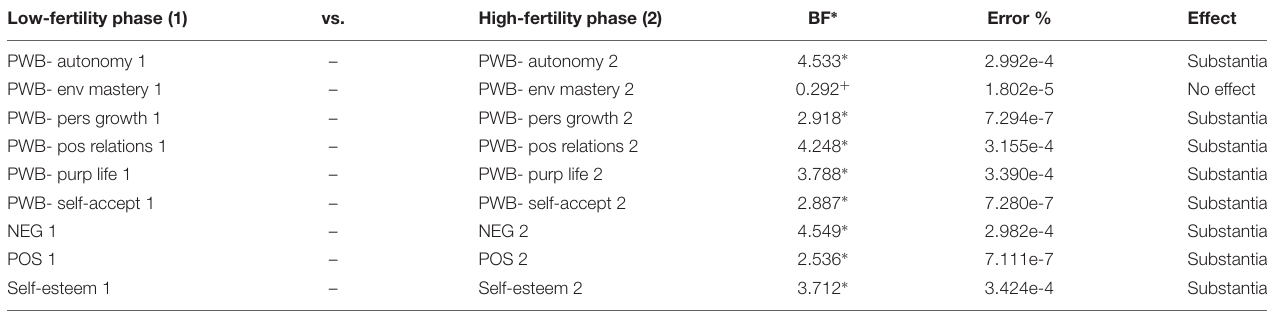
TABLE 1 | Bayesian paired samples t -test.